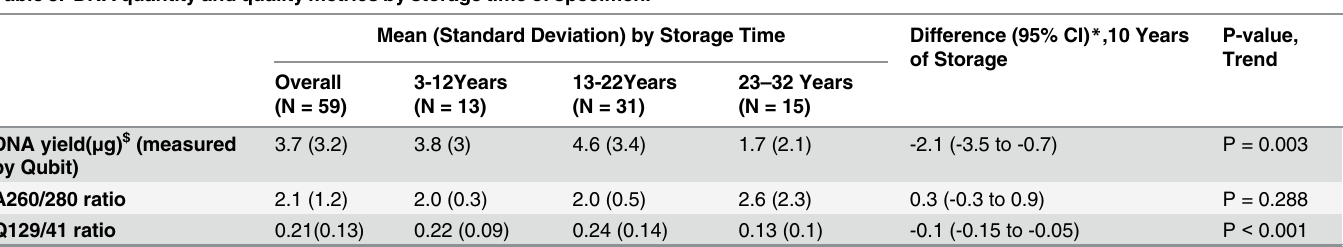
Table 3. DNA quantity and quality metrics by storage time of specimen.